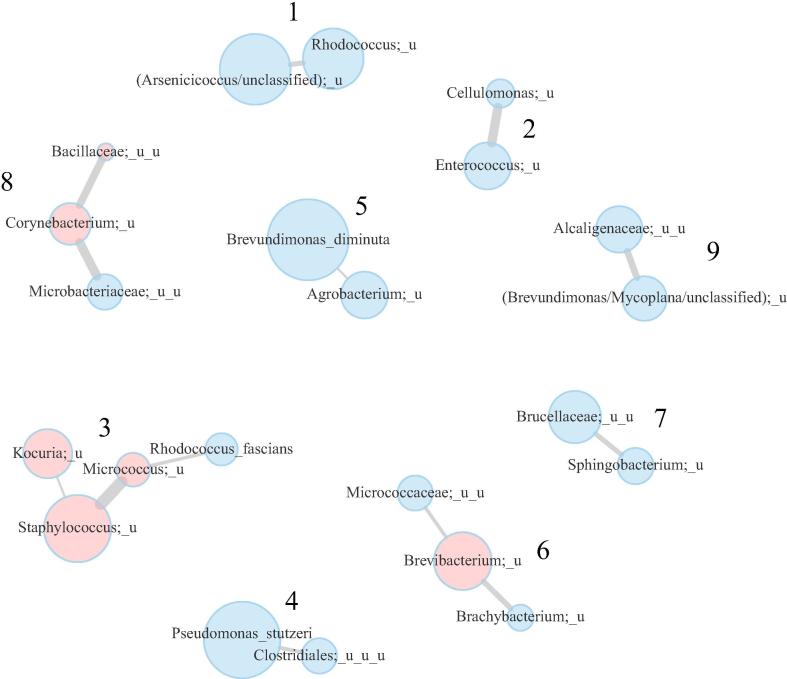
Microbial clusters (co-occurrence groups of species) calculated using SPIEC-EASI. Vertex diameter is proportional to the abundance of the taxon. The taxa likely originating from human microbiome are shown in pink. (For interpretation of the references to colour in this figure legend, the reader is referred to the web version of this article.)